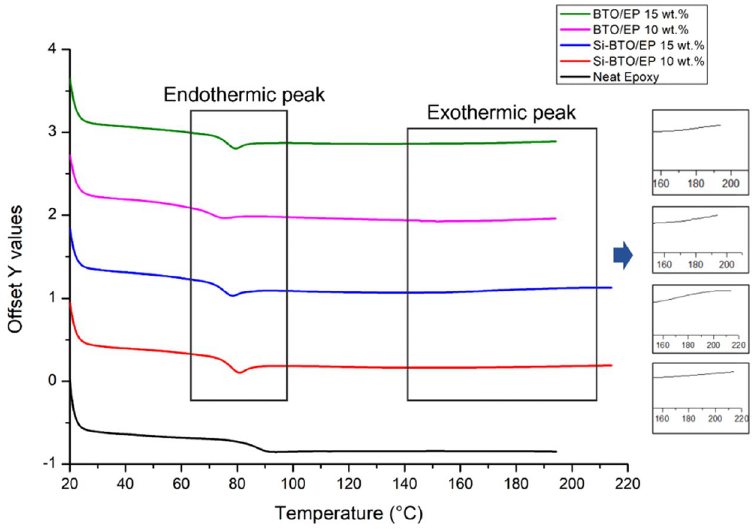
Figure 14. DSC spectra of neat epoxy and nanocomposites with 10 wt.% and 15 wt.% of untreated BaTiO 3 (pink and green) and Si-BaTiO